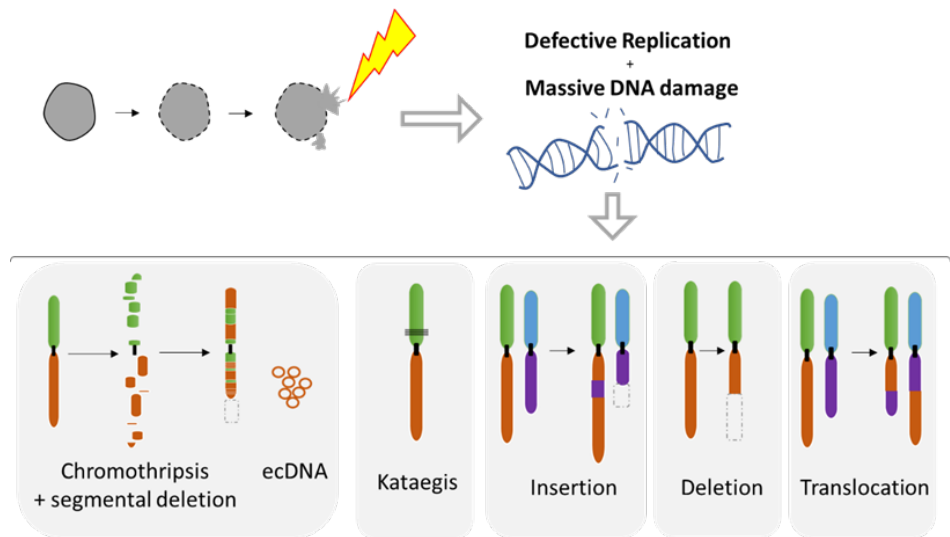
Figure 7. Chromosomal instability resulting from nuclear envelope disruption of micronuclei (MN). Defects in nuclear envelope of the micronuclei lead to it collapsing, resulting in defective replication and massive DNA damage. MN collapse is associated with a broad range of chromosomal rearrangements such as chromothripsis, the hyper mutated pattern kataegis, as well as the insertion, deletion, and translocation events. Circular chromosomes (ecDNA) are often associated with chromothripsis.